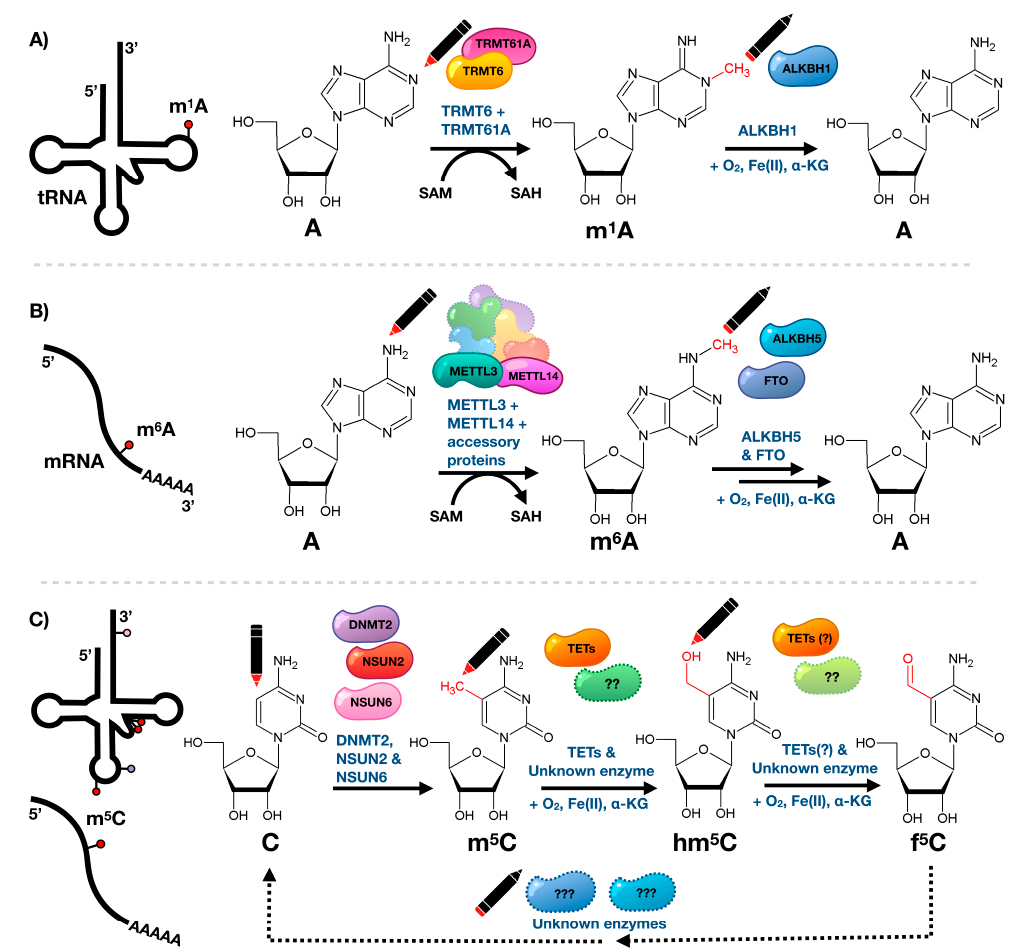
Figure 2. Reversibility and dynamics of RNA modifications. ( A ) The epitranscriptomic writer for the tRNA m 1 A modification is a TRMT6/TRMT61A complex, which uses S-adenosyl methionine (SAM) as a methyl donor. ALKBH1 removes the methyl group and requires oxygen, iron and α -ketoglutarate as cofactors for demethylase activity. ( B ) N 6 -Methyladenosine (m 6 A) is added to mRNA via the METTL3-METTL14 heterodimer, which along with accessory proteins forms the N 6 -methyltransferase complex using SAM as methyl donor. The modification is removed by ALKBH5 or FTO requiring oxygen, iron, and α -ketoglutarate cofactors. ( C ) 5-Methylcytidine (m 5 C) on cytosolic tRNAs is added by DNMT2, NSUN2, and NSUN6, while m 5 C on mRNA is introduced by NSUN2 only. It undergoes further oxidative metabolism mediated by TET enzymes (and possible other unknown enzymes) to 5-hydroxymethylcytidine (hm 5 C), requiring oxygen, iron, and α -ketoglutarate. Further TET activity results in formation of 5-formylcytidine (f 5 C) using hm 5 C as precursor. These modifications have not been shown to be fully reversible although it is predicted that there are erasers for m 5 C, or its metabolites [46–48].